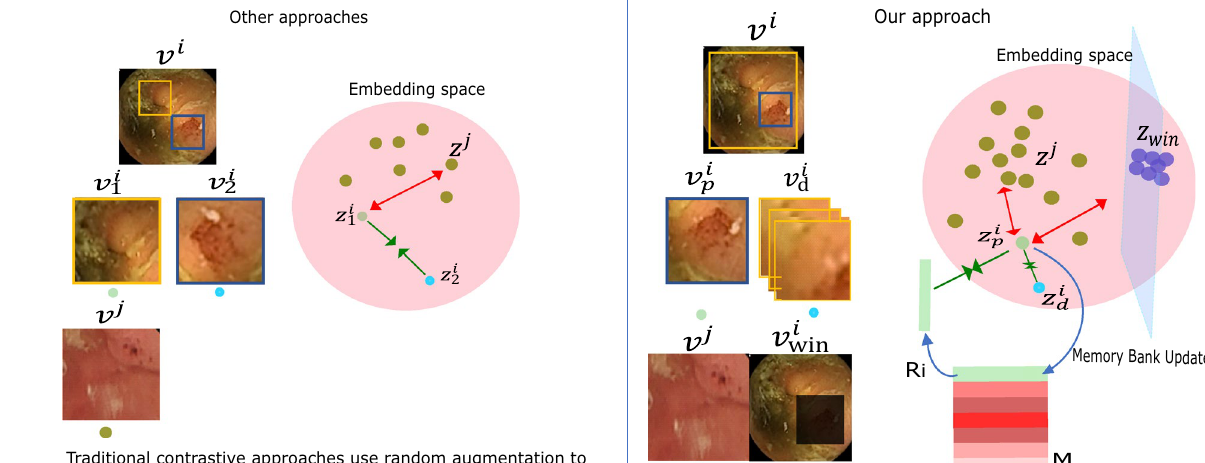
Figure 2. Overview of proposed objectives. ( a ) Two views v from the same image are encoded as z i p , z i d respectively. The contrastive objective uses these as well as representations R GN and R i from an evolving memory bank M to minimize distance between positives and maximize distance between negatives. ( b ) In addition to v in the batch (B) by removing regions suspected of pathology. These v win are transformed into z win and used as additional negatives. Refer to “Prior guided contrast (PGCon)” and “Within instance negative (WINCon)” sections for more